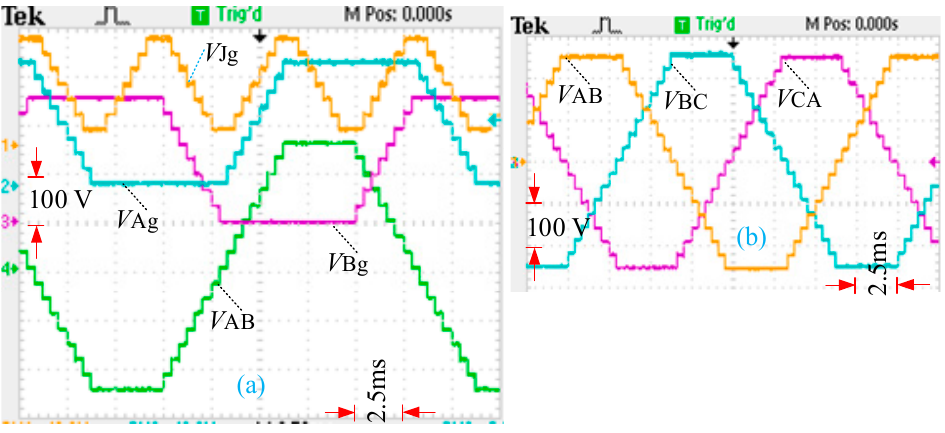
Figure 12. Experimental results, ( a ) Junction voltage, pole voltages ( V Ag , V Bg ), line voltages ( V AB ); ( b ) 17-level three-phase line voltages.